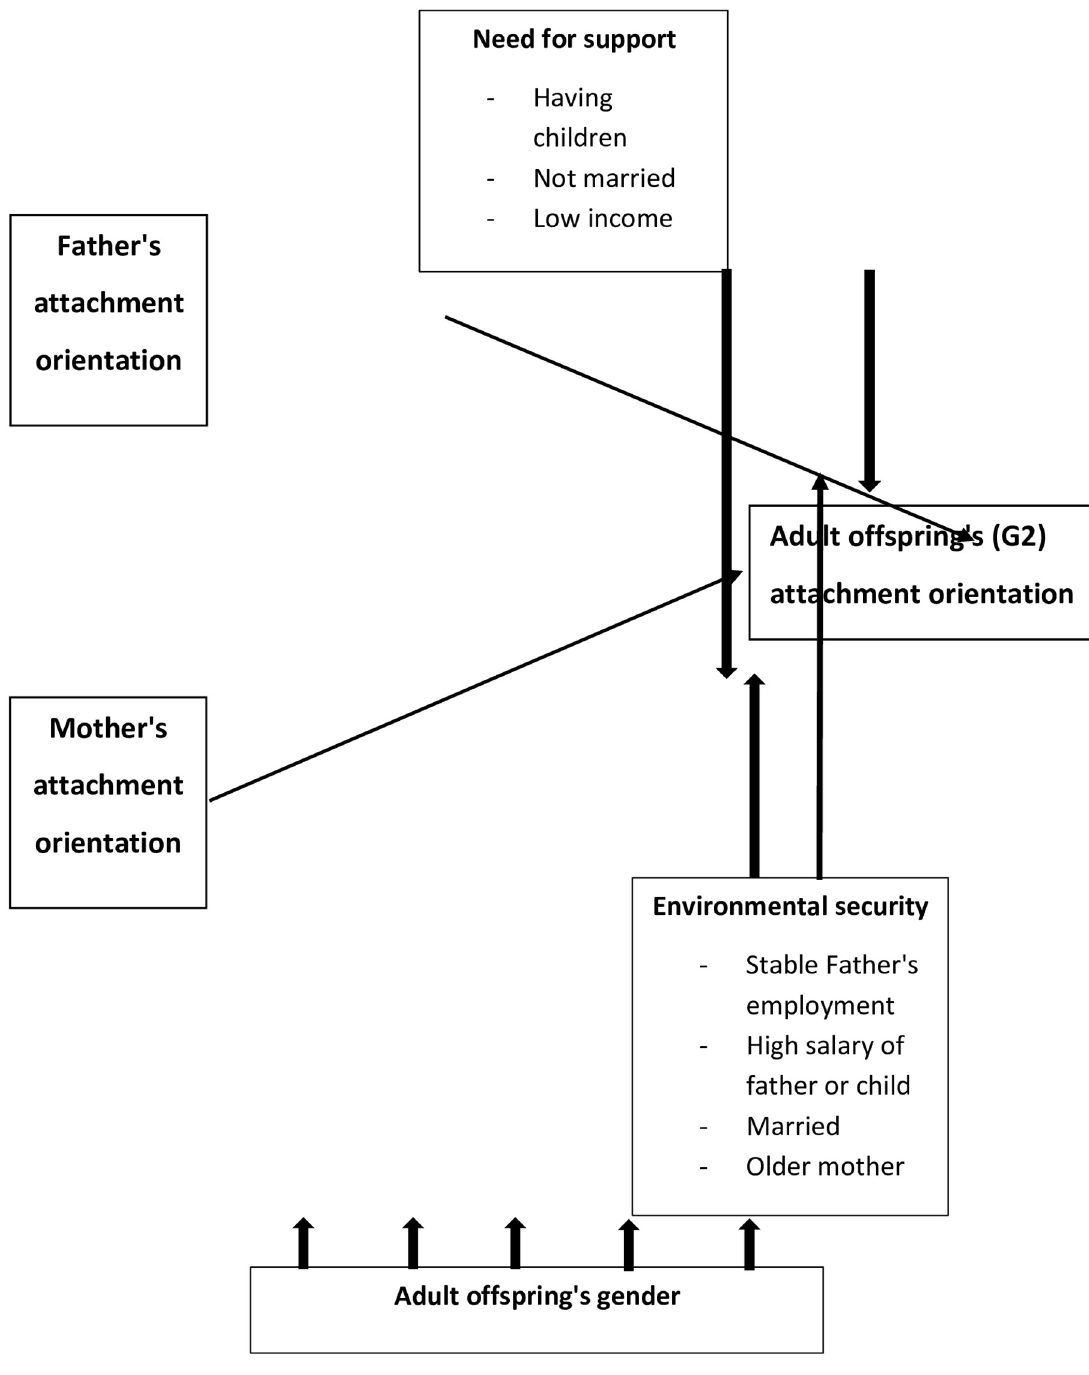
Each participant filled in the questionnaire at home and later returned it directly to the investi- gators. All participants were instructed to work through the packet of questionnaires at their own pace but in the order of presentation. After completing the questionnaires, participants were debriefed and thanked for their